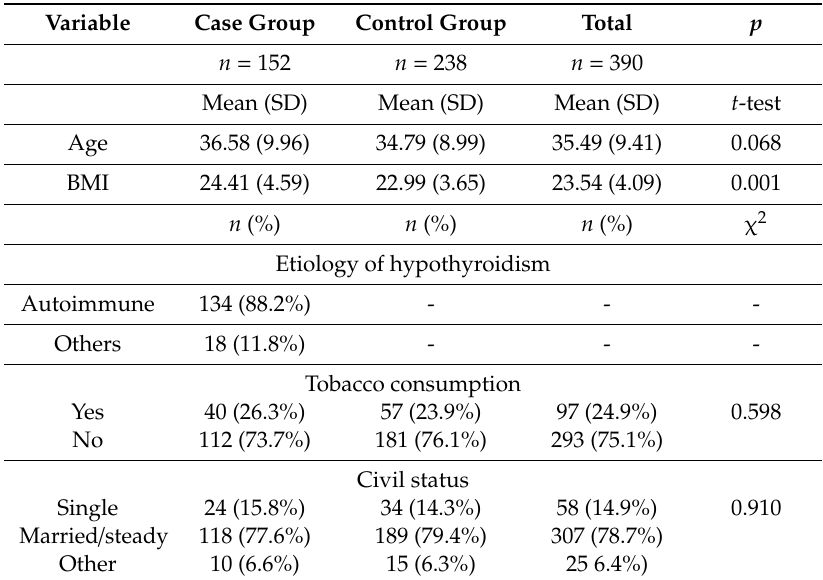
Table 1. Sociodemographic and clinical